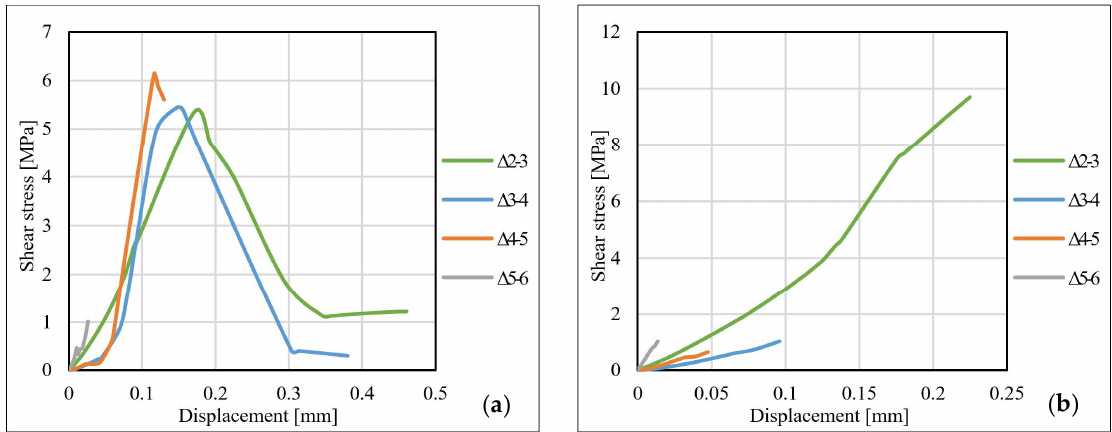
Figure 15. Bond–slip curves for specimens: ( a ) NS-S512-30-1-II and ( b ) NS-M514-330-1-I. For the specimens made with Sikadur 330 adhesive, in most of the cases, the shear stress–displacement curves are characterized by a single upward plateau. The failure mechanisms that were identified in the case of these joints occurred mostly at the adhesive–CFRP strip interface in a brittle and sudden manner (non-cohesive).